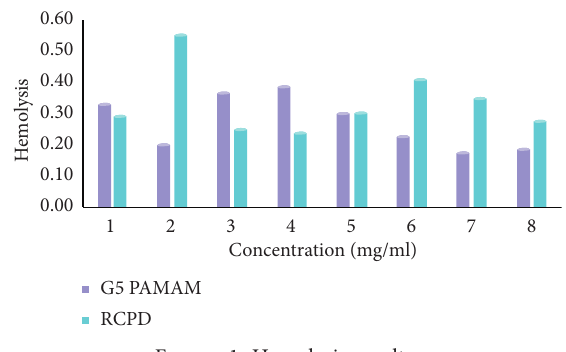
Figure 1: Hemolysis